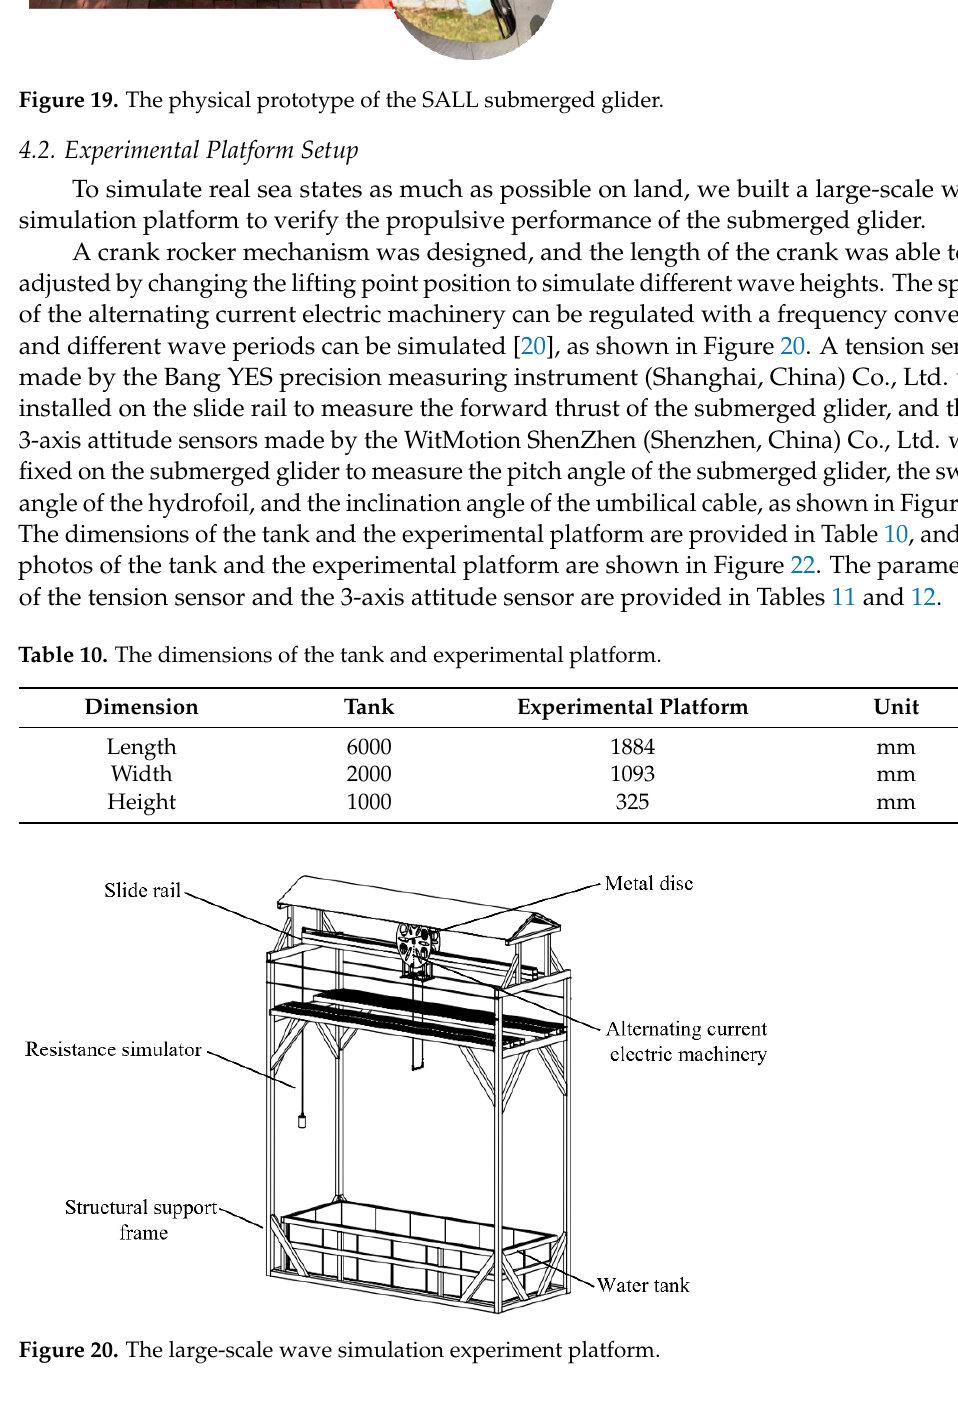
Figure 21. The SALL submerged glider in the tank experiment. Table 10. The dimensions of the tank and experimental platform. Dimension Tank